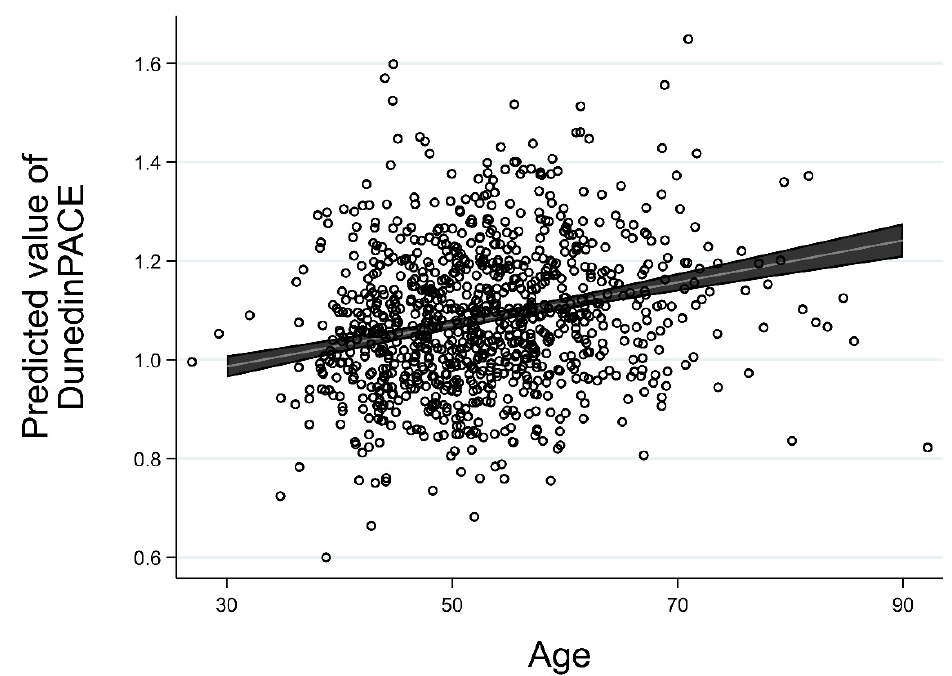
Figure 1. Results from the unconditional linear growth model of DunedinPACE as a function of age, with individual data points shown.